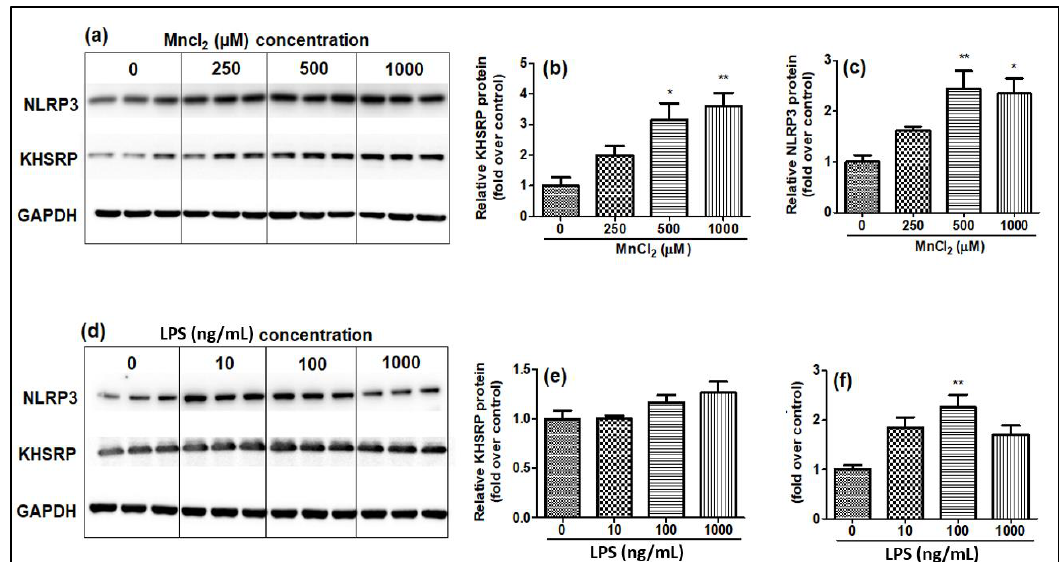
Figure 3. Effect of MnCl 2 and LPS on protein levels of KHSRP and NLRP3 quantitated by Western blot analysis 24 h post-exposure, relative band intensity quantified ( a ) Western blot analysis for the impact of MnCl 2 exposure on NLRP3, KHSRP, GAPDH, ( b ) fold change in KHSRP protein levels (relative quantification) post-MnCl 2 exposure, ( c ) fold change in NLRP3 protein post-MnCl 2 exposure, ( d ) Western blot analysis for the impact of LPS exposure on NLRP3, KHSRP, GAPDH, ( e ) fold change in KHSRP protein levels (relative quantification) post-LPS exposure, ( f ) fold change in NLRP3 protein post-LPS exposure. Protein intensity values were normalized to the housekeeping protein, GAPDH, and expressed as a fold-induction over the control sample (set at a value of 1). Data represented as mean ± SEM. * p < 0.05, ** p < 0.001.